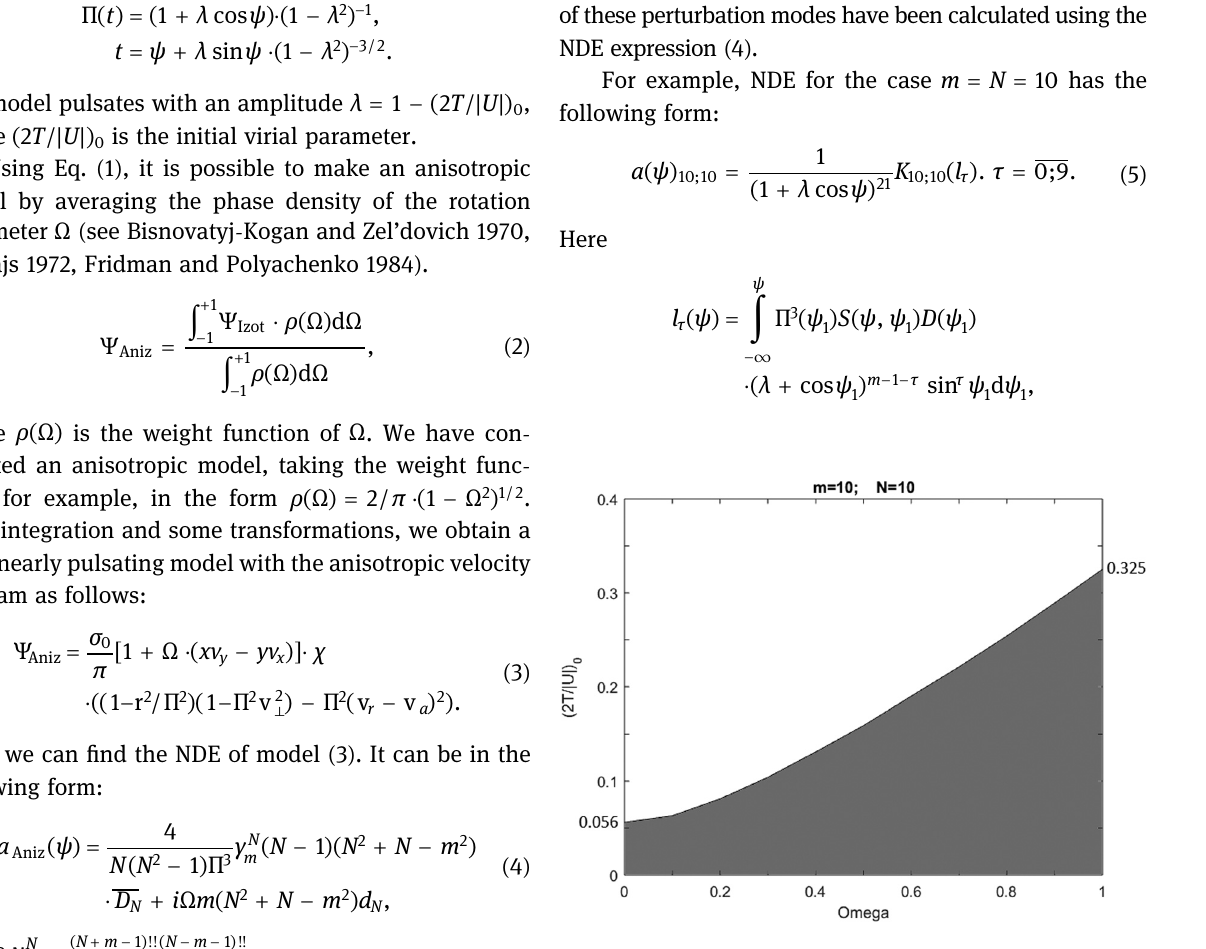
Figure 1: Critical dependence of the virial ratio on the rotation parameter for m 10 = ; N 10 =